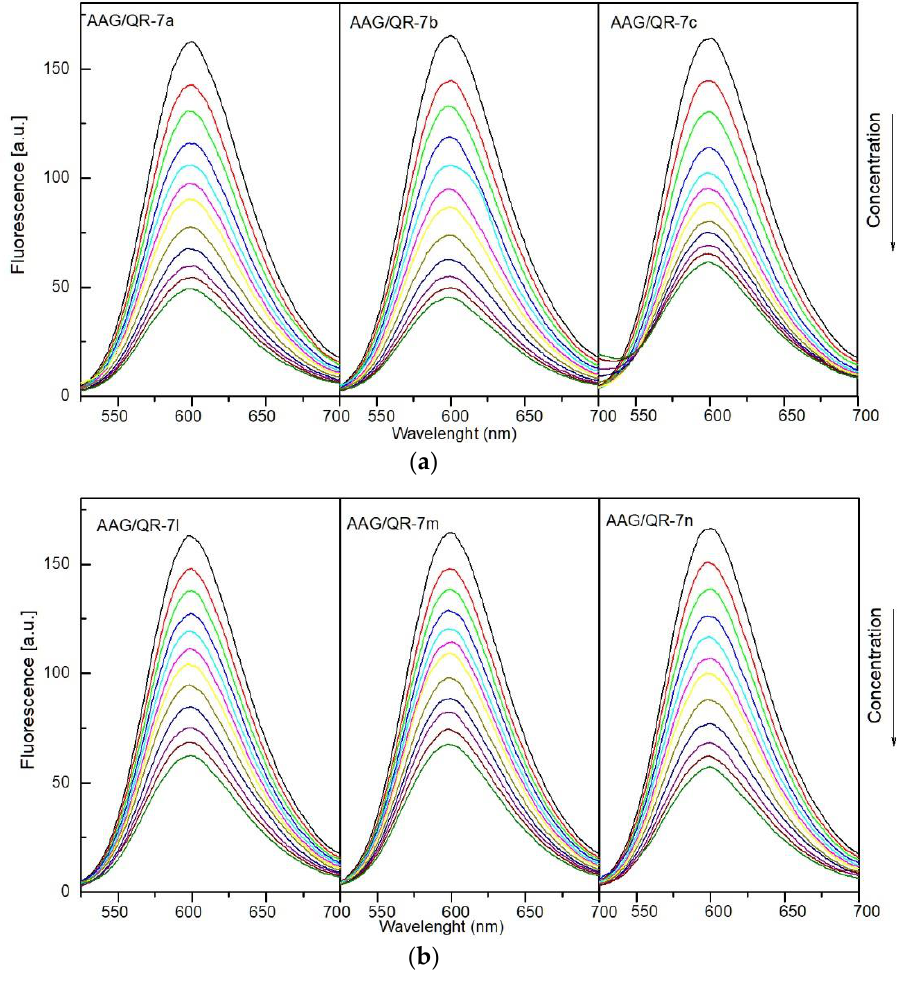
Figure 9. ( a ) Fluorescence quenching spectra of the alpha-1-acid glycoprotein (AAG)/QR system in the presence of different concentrations of compounds 7a – 7c (T-297 K, λ ex = 500 nm). The concentration of 7a – 7c were 0, 0.5, 1, 2, 3, 4, 5, 7, 9, 11, 13, 15 µ M. ( b ) Fluorescence quenching spectra of alpha-1-acid glycoprotein (AAG)/QR system in the presence of different concentrations of compounds 7l – 7m (T-297 K, λ ex = 500 nm). The concentration of 7l – 7m is 0, 0.5, 1, 2, 3, 4, 5, 7, 9, 11, 13, 15 µ